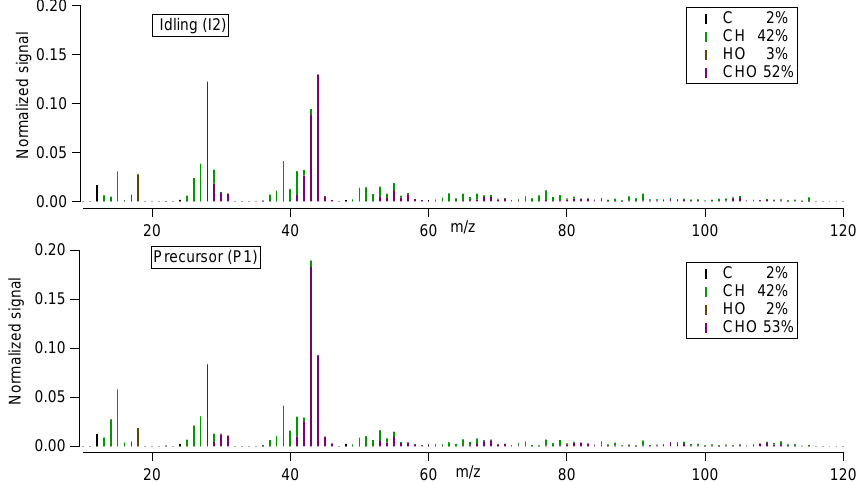
Fig. 6. Normalized high-resolution MS of OA at the end of gasoline exhaust experiment I2 and precursor mixture experiment P1 (toluene, m-xylene, 1,2,4-TMB). The ion fragments detected have been grouped into four families: C containing only carbon; CH containing only carbon and hydrogen; HO containing only oxygen and hydrogen; and CHO containing carbon, hydrogen and oxygen. The POA contribution in experiment I2 was < 0.5%.